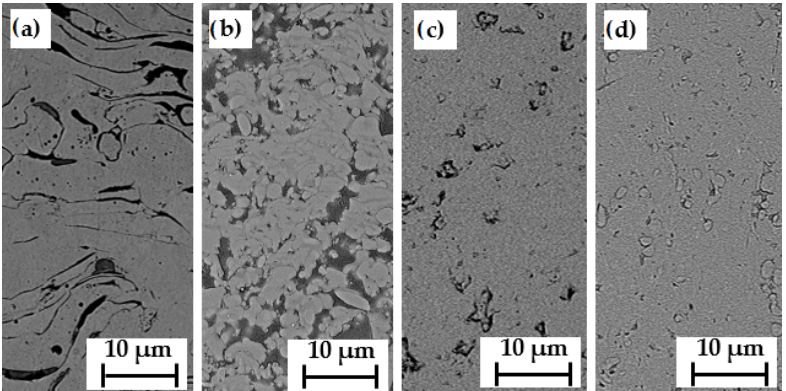
Figure 3. SEM cross-section micrographs of Al 2 O 3 coatings sprayed by: ( a ) APS, ( b ) SPS, ( c ) A-SPS and ( d ) S-HVOF.